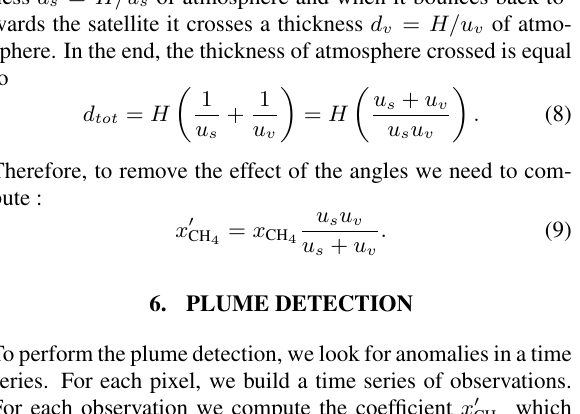
on several observations CH 4 plume.